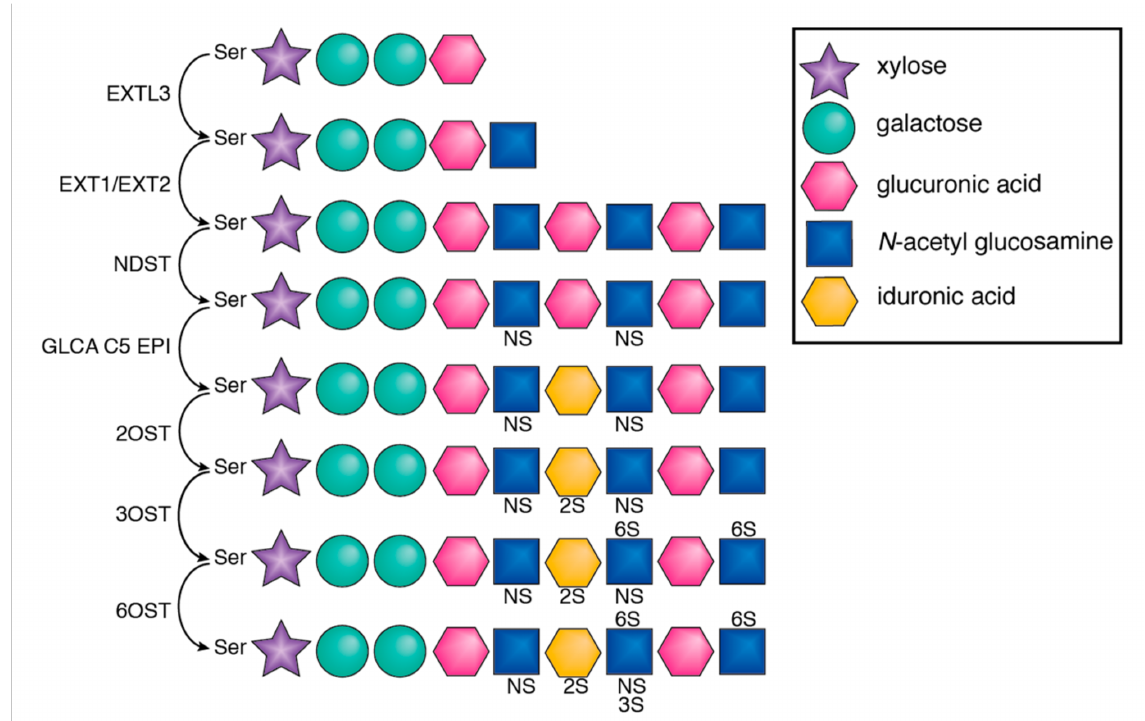
Figure 2. HS synthesis pathway. The glycans are attached to the protein core through a serine linker. After the addition of di ff erent sugars, O - and N -sulfotransferases further modify the side chain conferring the negative